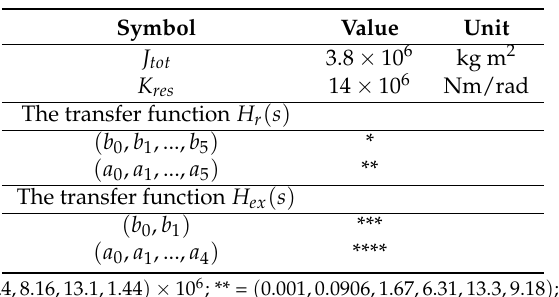
Table 1. Model parameters for the